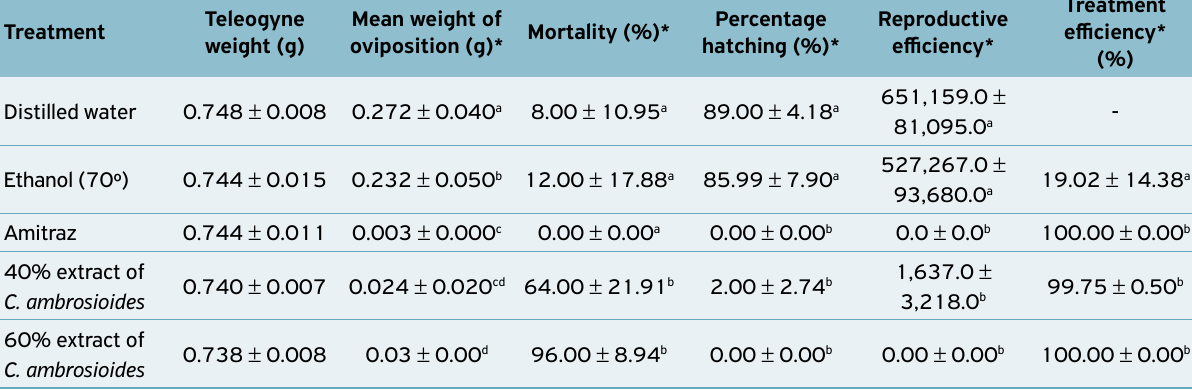
*Different letters in the columns indicate significant differences (P < 0.05) according to the Kruskal-Wallis test.